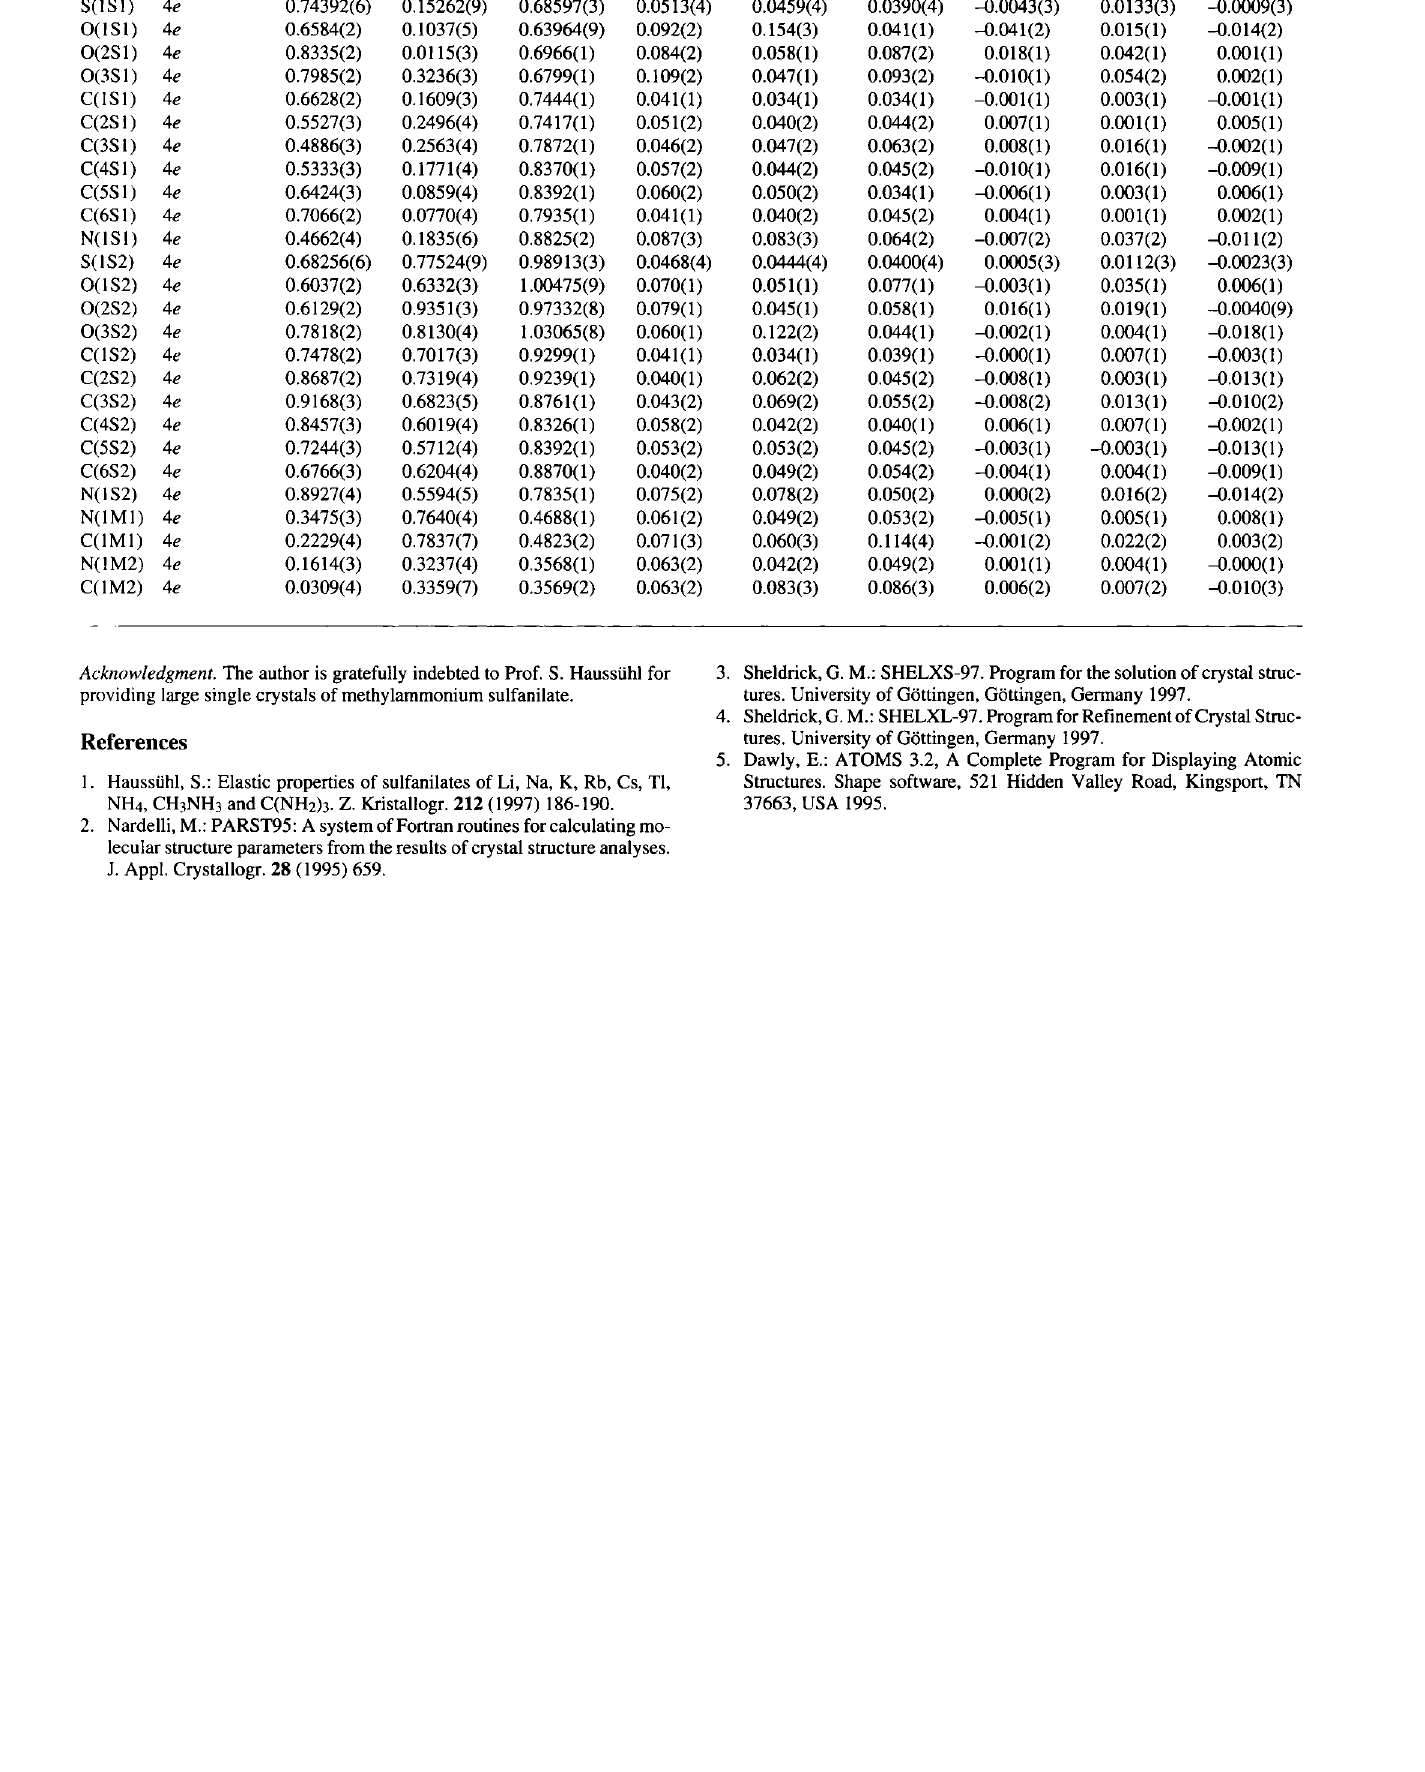
Table 3. Atomic coordinates and displacement parameters (in Â 2